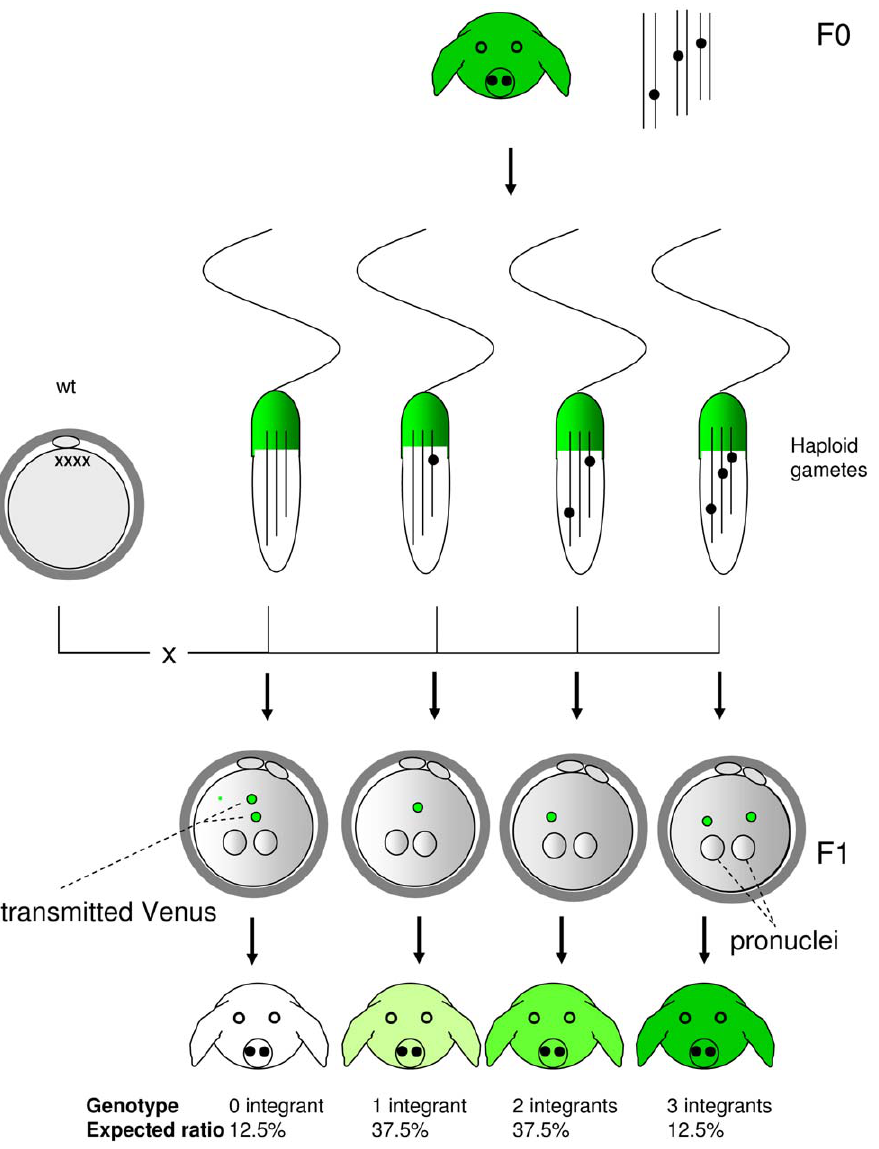
Figure 6. Genotype-independent transmission of a transgenic fluorophore protein by spermatozoa. In founder (top) and F1-offspring (bottom) a direct correlation between genotype and phenotype is found. The genotype is depicted by lines representing chromosomes, dots indicate monomeric copies of the transgene; the phenotype is depicted by graded intensities of green color. However, in mature haploid spermatozoa a uniform phenotype is found, despite segregation of transgenes and a different transgene load in different sperm cells. Even the , 10% spermatozoa, which did not carry any transgene copy, showed a uniform Venus expression. The data presented here, suggest that the uniform phenotype in spermatozoa is due to a highly accurate distribution of Venus protein between immature spermatozoa. Most likely several paternal proteins might be equally distributed by this mechanism between immature spermatozoa.